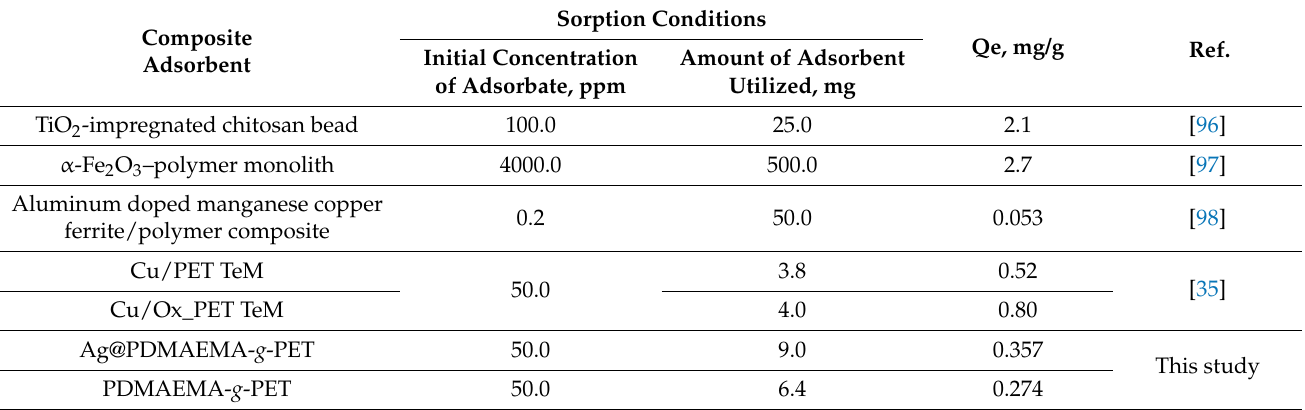
Table 3. Comparative adsorption capacity of the prepared TeMs and other composite sorbents towards the adsorption of